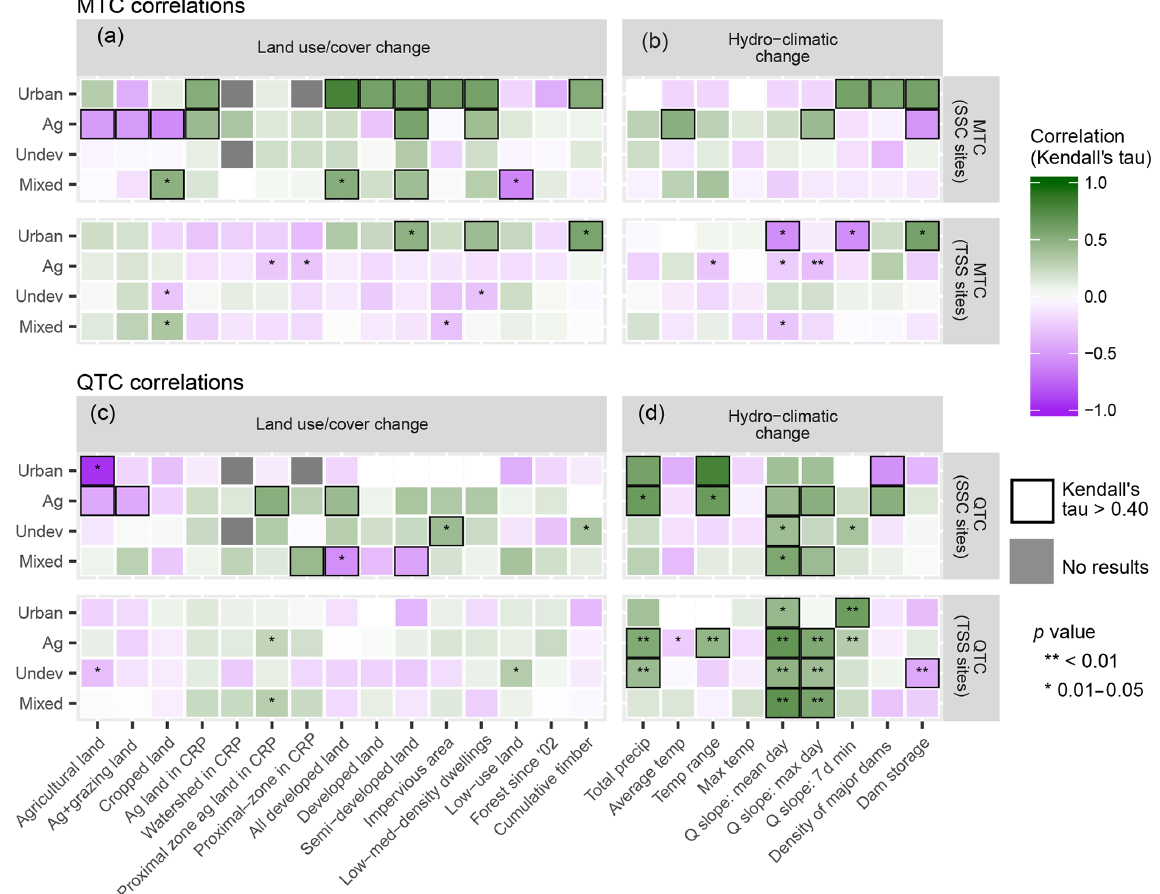
Figure 7. Correlations between MTC or QTC and land use/cover or hydro-climatic-change variables by sediment parameter. Sites grouped by 2012 land use of contributing